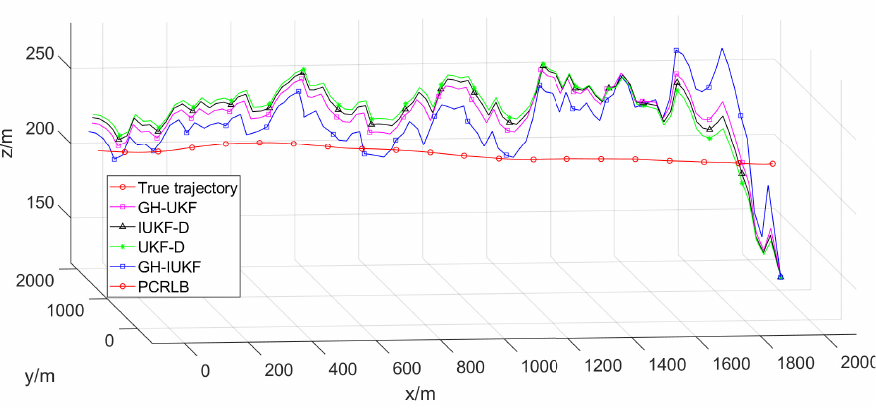
Figure 4. Tracking trajectory in 3D space.